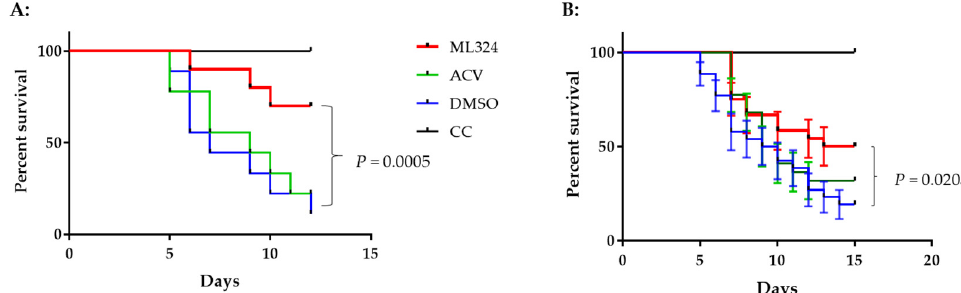
Figure 7. Survival of CyHV-3-infected younger koi treated with ML324, ACV, or DMSO. ( A) Survival of koi infected with CyHV-3 in treated and untreated groups. Three to four-month-old koi in a single tank were infected with 1 × 10 3 PFU/mL for 30 min as described in Figure 6A. ( B ). The average survival of younger koi infected with CyHV-3 in three different tanks with ML324, ACV, or DMSO. A significant statistical difference between the DMSO-treated and ML324 treated is marked with a p -value calculated using a two-way ANOVA.